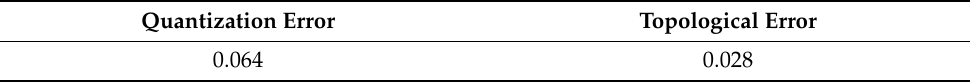
Table 3. Self-organizing maps (SOM) error metrics for the Ti-Nb-Zr-Sn